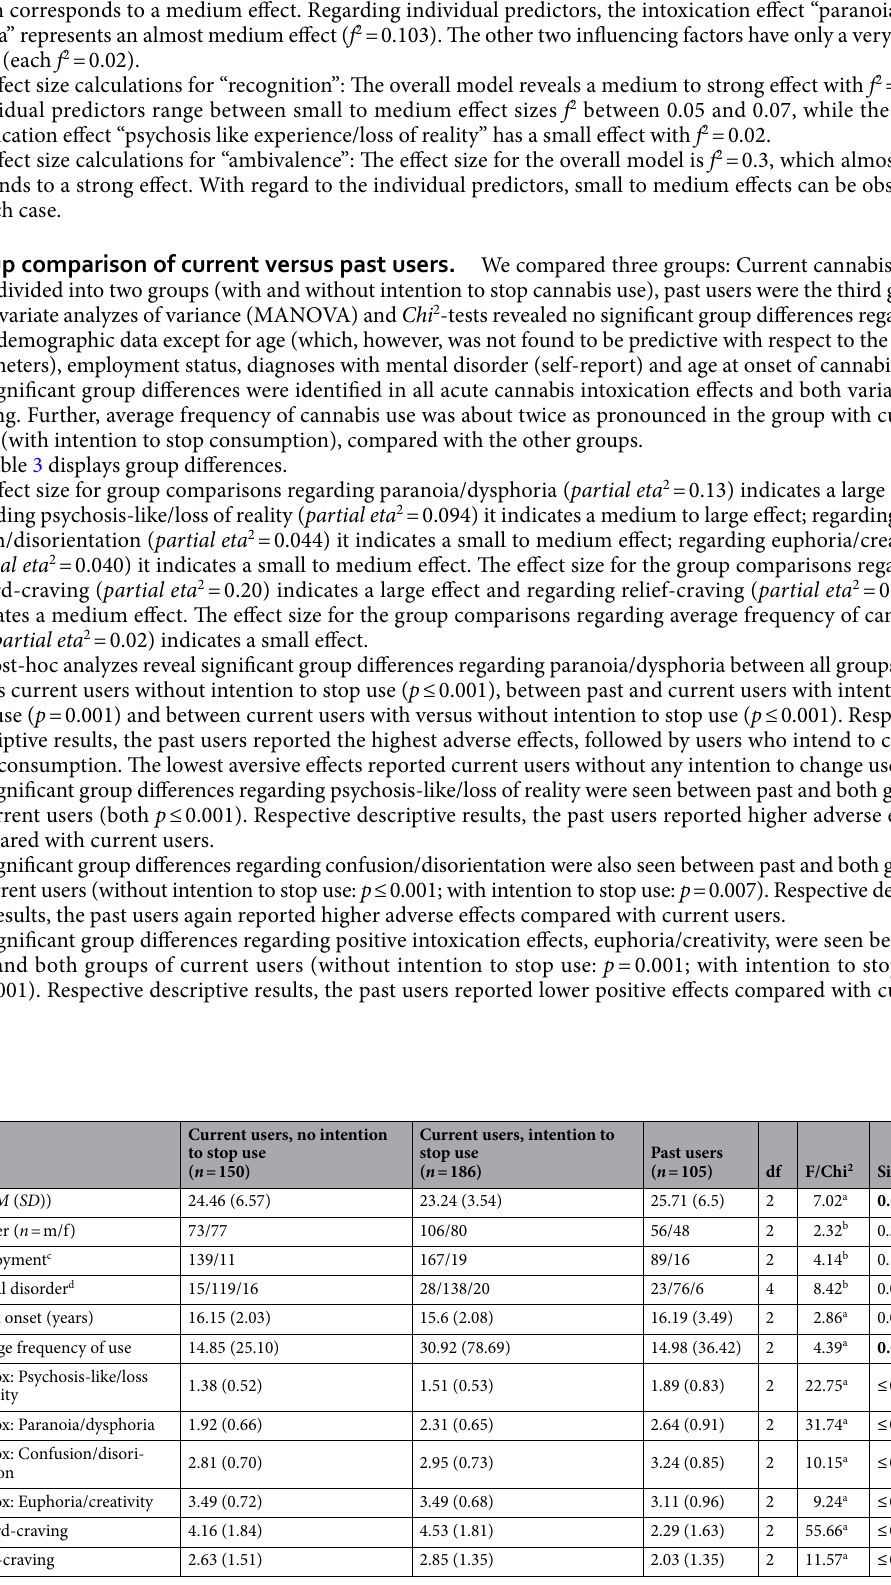
Table 3. Group-comparison of current (with and without intention to stop use) and past cannabis users. CanTox, Cannabis-intoxication questionnaire; a F-value; b Chi 2 value; df, degrees of freedom; Sig., level of significance; c Employed, in training/unemployed; d Diagnosis